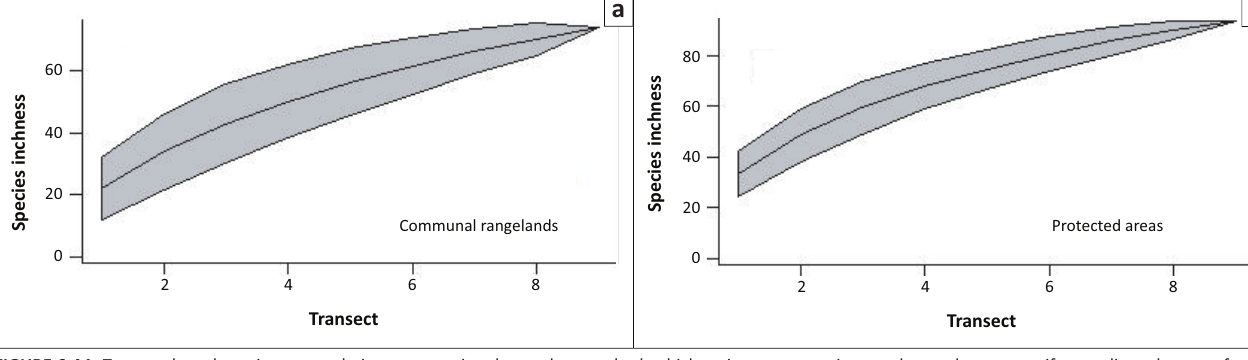
FIGURE 6-A1: Transect-based species accumulation curves using the random method, which assigns transects in a random order to quantify sampling adequacy, for (a) the nine transects in communal rangelands and (b) the nine transects in protected areas. Grey shading represents the 95 % confidence interval for the extrapolated